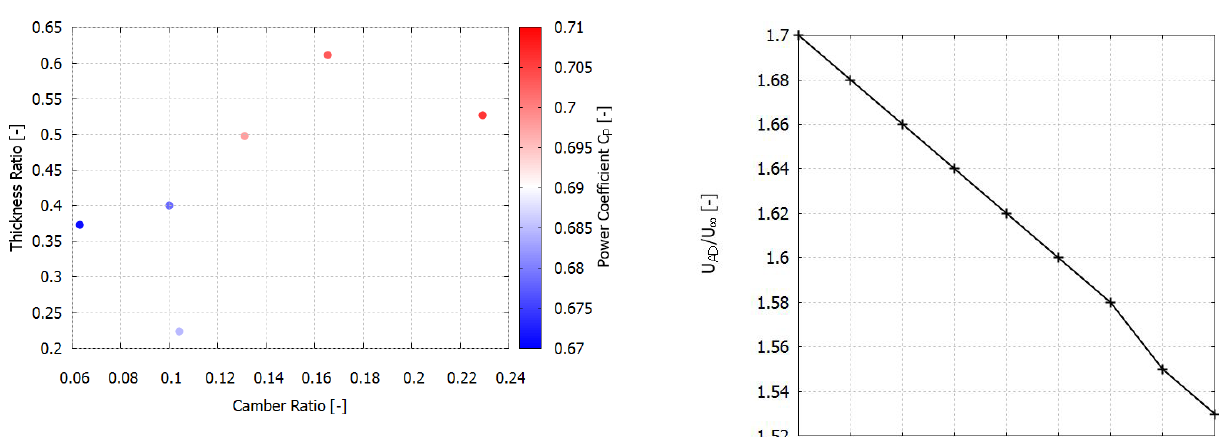
Figure 8. Effect of camber and thickness of the diffuser on the C P for the airfoils in the third stage.